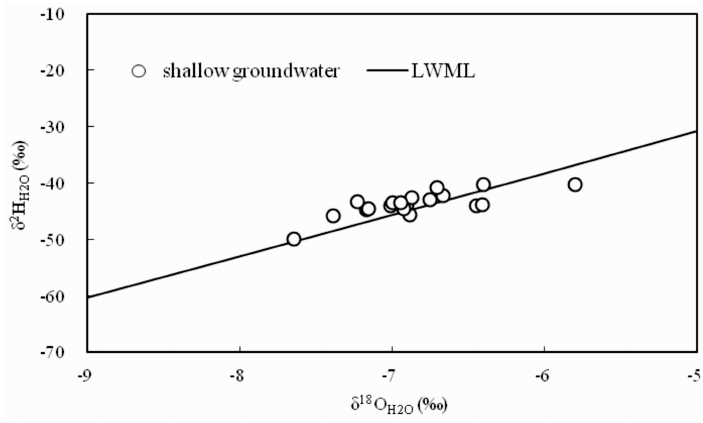
Figure 4. Stable isotopes of shallow groundwater and its relationship with the local water meteoric line.